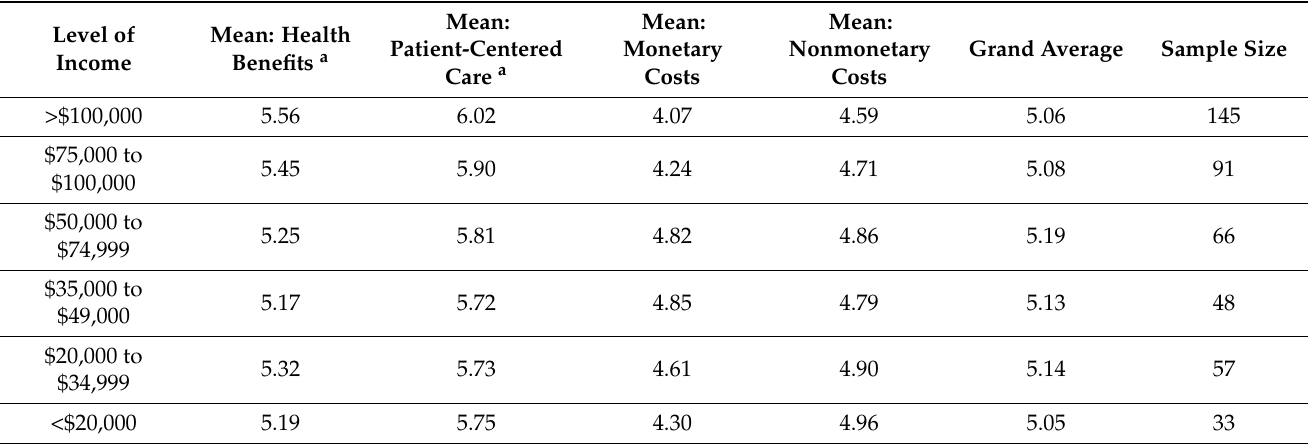
Table 5. Means for Dimensions of Patient Satisfaction by Patient Income Level.